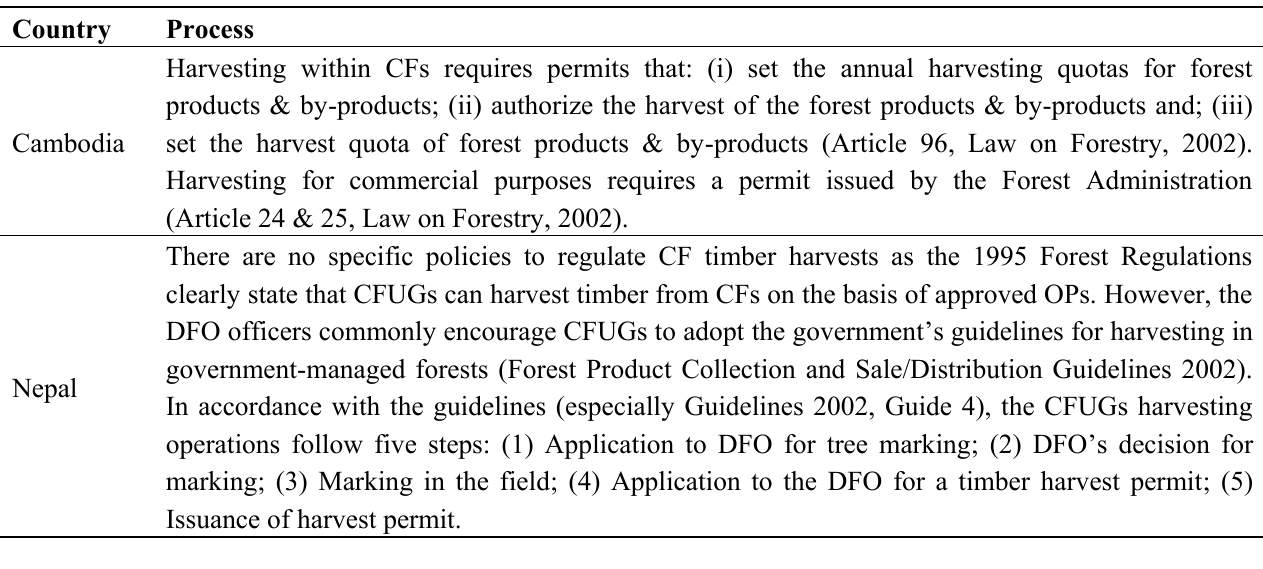
Table 4. Details of requirements for conducting harvesting in community forests in each country